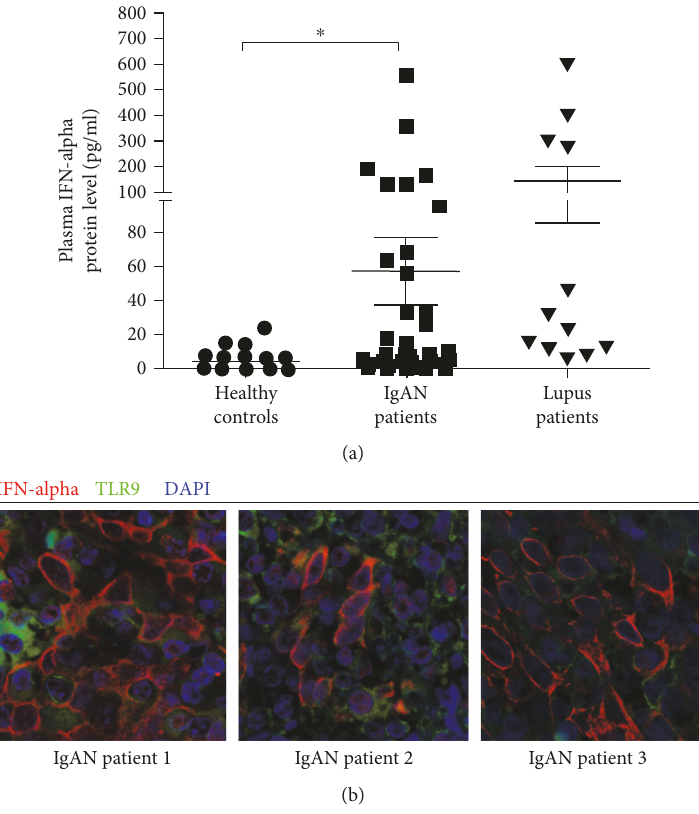
Figure 2: (a) Concentrations of IFN- α proteins in plasma were measured in di ff erent groups. PBMCs of di ff erent donors were prepared by fi coll-paque density centrifugation, and plasma in upper layer was harvested for ELISA analysis. ∗ p < 0 05 . (b) Para ffi n-embedded sections of tonsil from IgAN patients with tonsillitis were stained for IFN- α and TLR9 expression. Table 1: Clinical and demographic features of IgAN patients and healthy